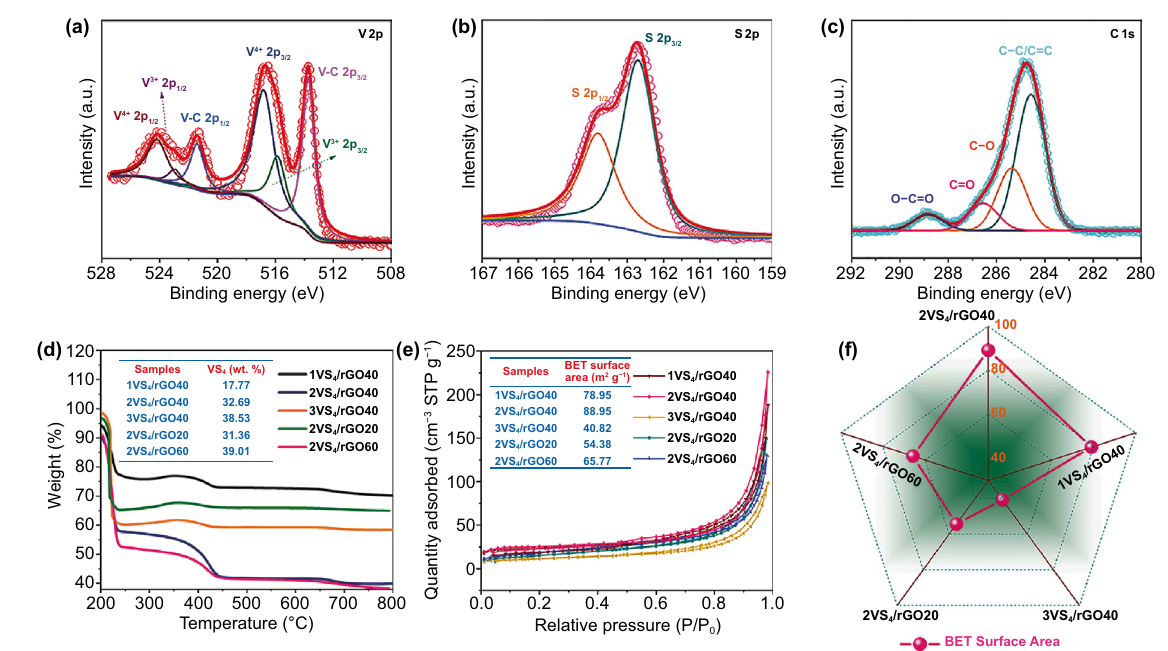
Fig. 3 XPS spectra of VS 4 /rGO heterostructures: a V 2p, b S 2p, c C 1s. d TGA curves of VS 4 /rGO heterostructures. e Nitrogen adsorption– desorption isotherms. f Different BET surface areas of VS 4 /rGO